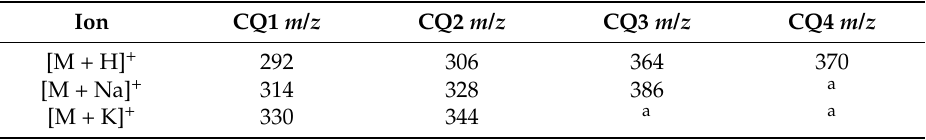
Table 3. Ionic species observed in the electrospray ionization mass spectrometry (ESI-MS) spectra of